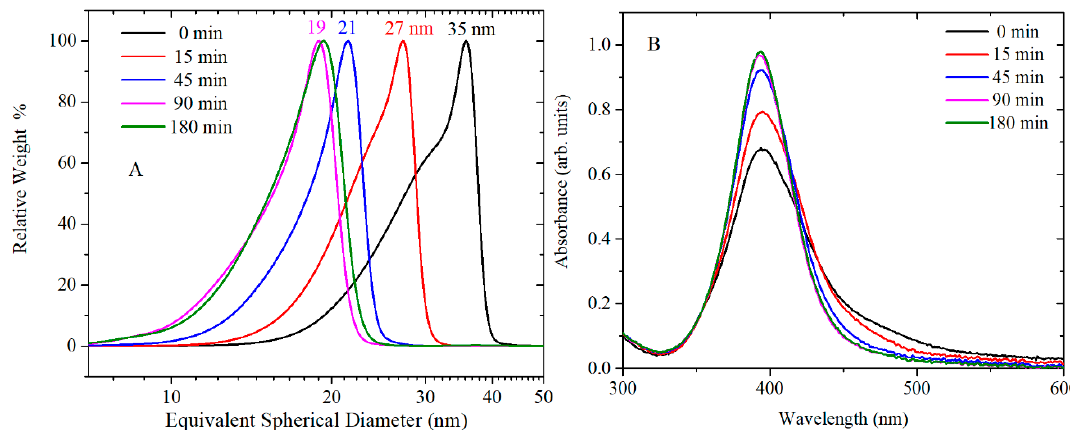
Figure 5. ( A ) CLS results and ( B ) UV-vis spectra of AgNPs synthesised using a fixed concentration [2 × 10 − 6 M] of TA solution thermally preconditioned for different times: 0, 15, 45, 90 and 180 min. CLS and UV-vis spectra show that, by increasing the preconditioning time of TA, smaller sizes and narrower size distributions of AgNPs were obtained.